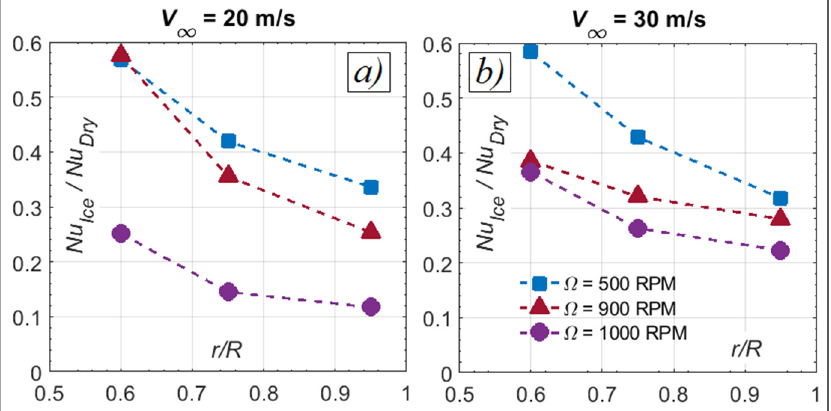
Figure 17. Ratios of the Calculated Nu Ice to Nu Dry for the De-Icing Tests at T ∝ ≈ 258.15 K and ( a ) V ∝ = 20 m/s and ( b ) V ∝ = 30 m/s.